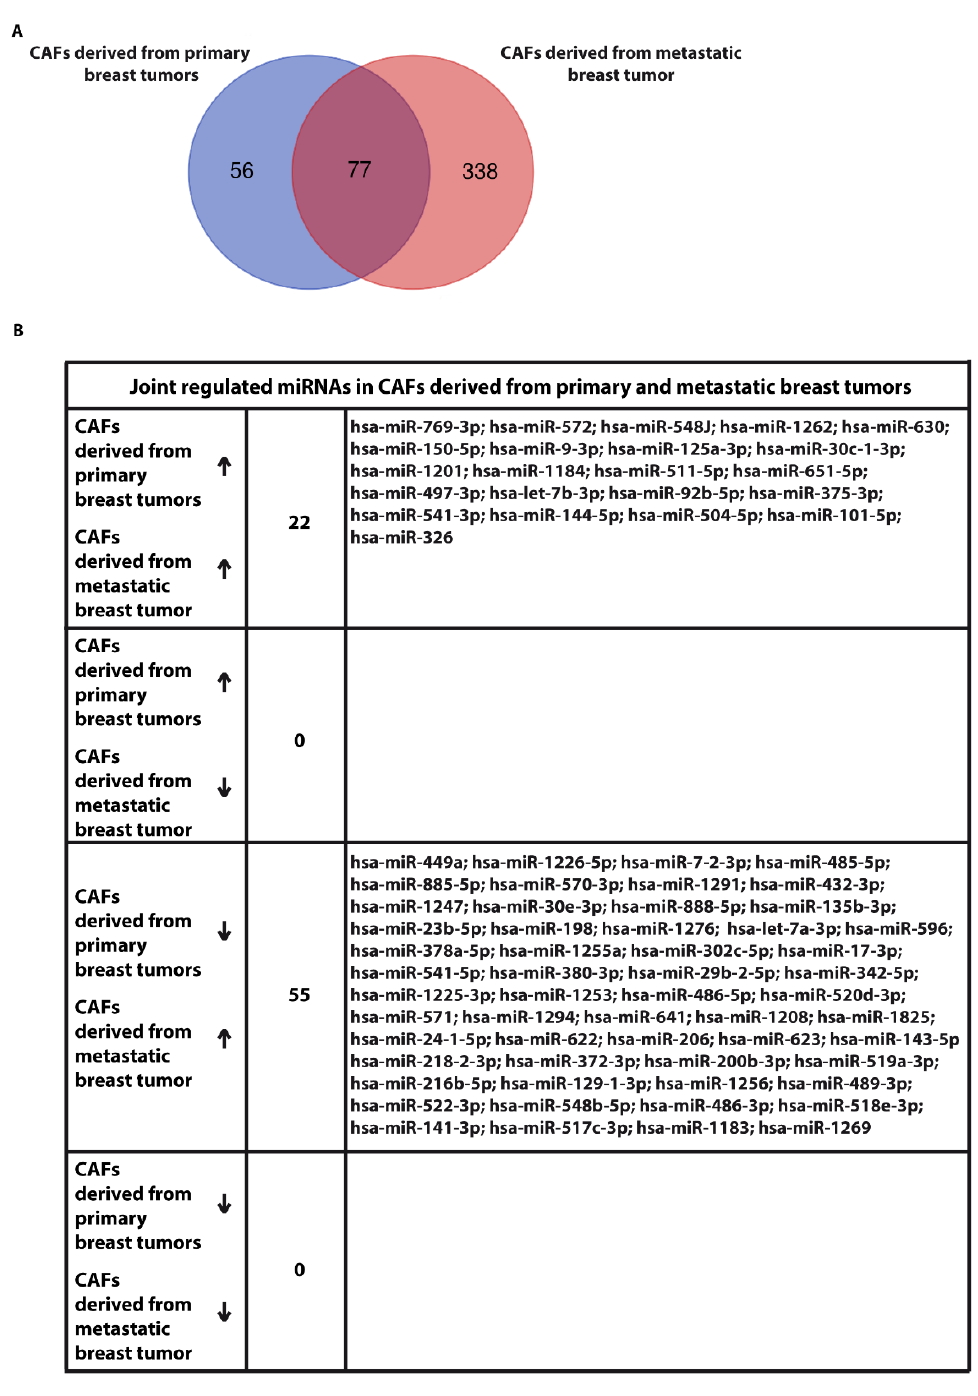
Figure 8. ( A ) Venn diagram of unique and joint E2-modulated miRNAs in CAFs derived from primary breast tumors and CAFs derived from a cutaneous metastasis of breast tumor. ( B ) up and downregulation of joint miRNAs (77) in CAFs derived from primary breast tumors and CAFs derived from a cutaneous metastasis of breast cancer and treated for 4 h with 100 nM E2.